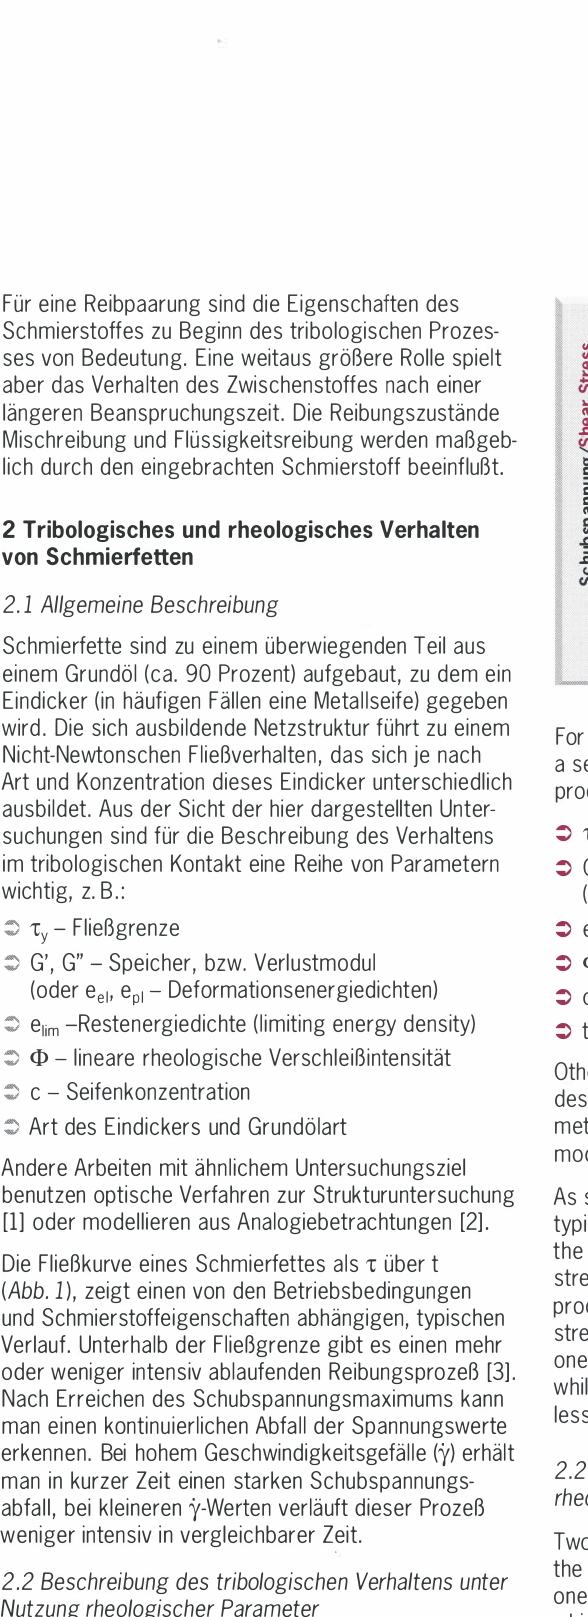
Fig. 1: Typical flow